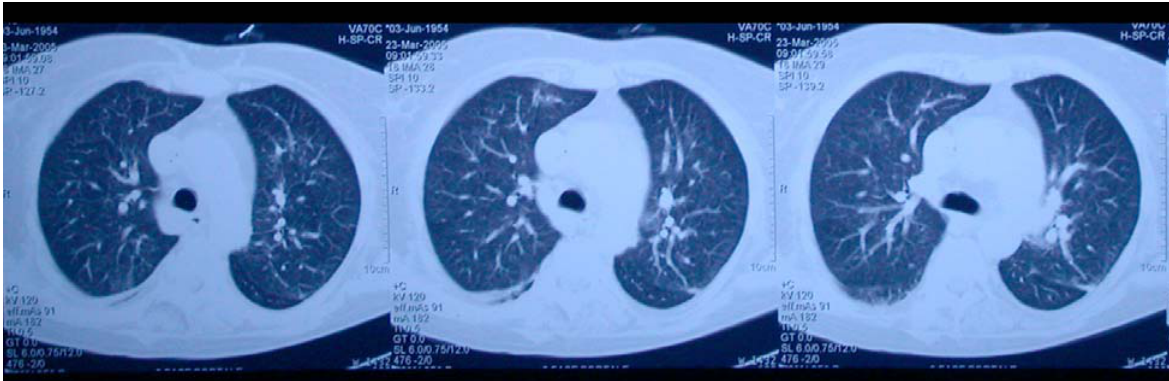
FIGURE 3. CT image of thorax showing diffuse ground glass opacification, bilateral patchy